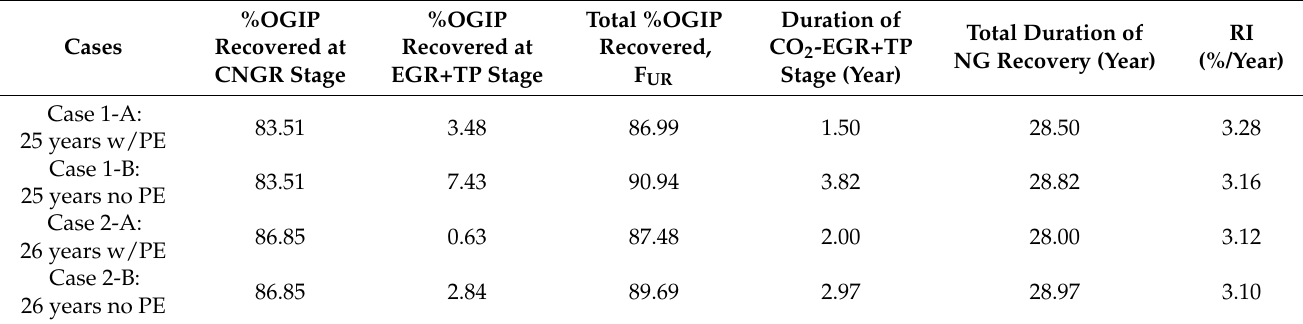
Figure 3. Two-phase wellbore flow regime plot showing the total mass flowrate of all fluids [kg/s] over the gas-phase mass fraction [kg/kg] at the bottom of the production well defined as X G − well = S G − well , where S G − well is the gas-phase saturation in the well, S L − well is the water-phase saturation in the well, and (cid:36) denotes density. The plotted symbols show the lowest gas-phase mass fraction points of the four investigated cases (Table 2) for three production well diameters, D . The lines indicate the minimum flowrate required to achieve the annular flow regime in the production well. Hence, conditions above each line indicate the annular flow regime, while conditions below each line indicate the undesired slug/churn flow regime in the production well. Table 3. Simulation results of the percentages of the original gas in place (OGIP), recovered during the CNGR and CO 2 -EGR+TP stages, and associated natural gas recovery index